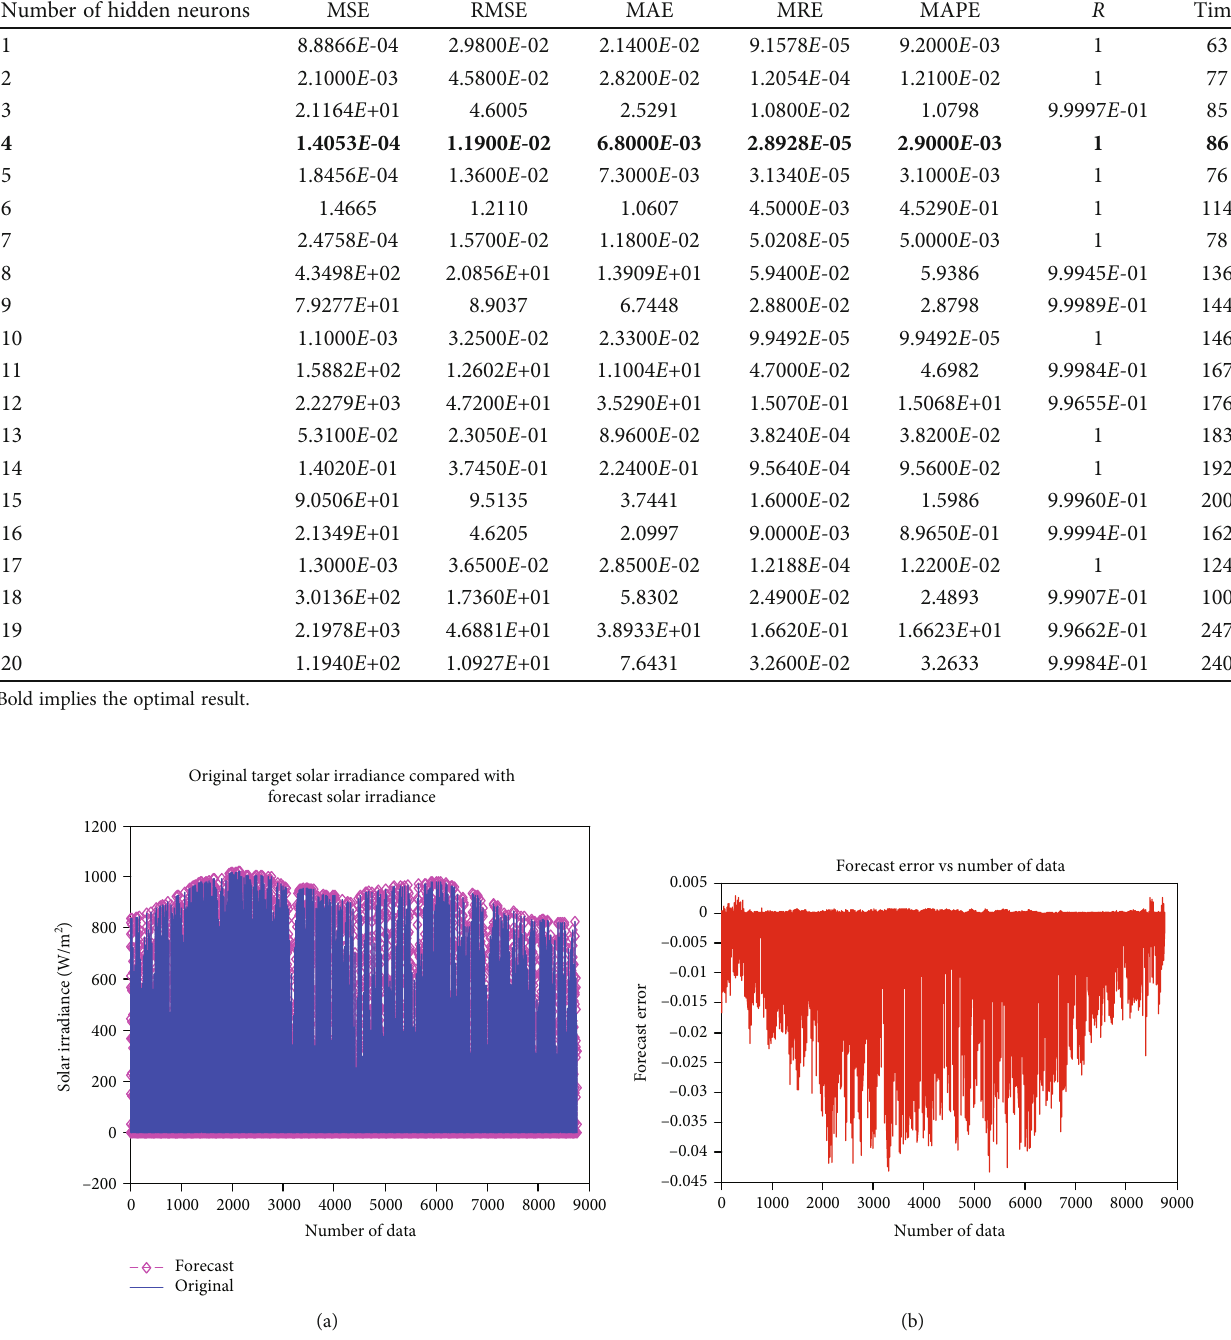
Table 6: Five input multilayer perceptron neural network performance analyses with di ff erent numbers of hidden neurons. Number of hidden neurons